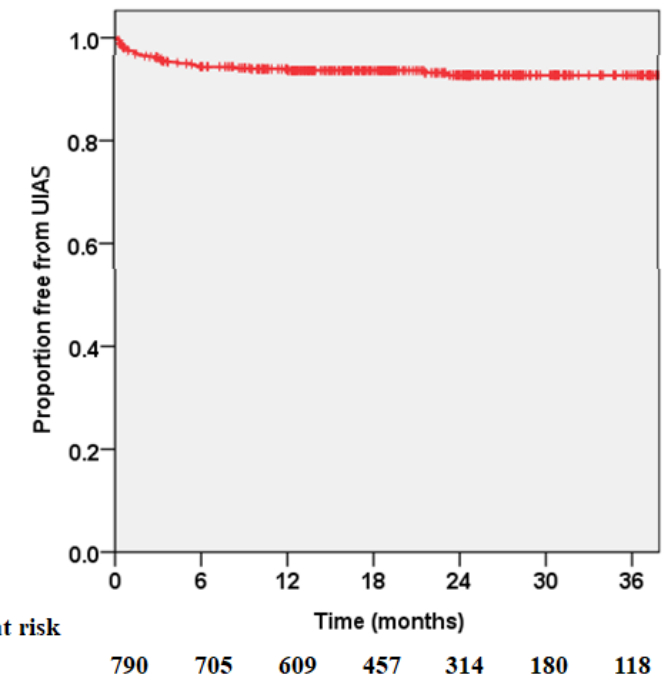
Figure 1. Kaplan–Meier curve showing the overall uretero-intestinal anastomosis stricture-free rate after radical cystectomy with ileal orthotopic neobladder.